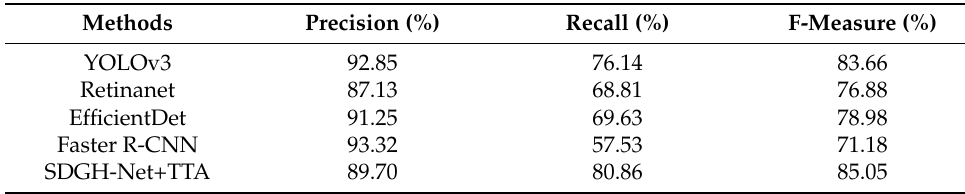
Table 1. Precision, recall, and F-measure of all